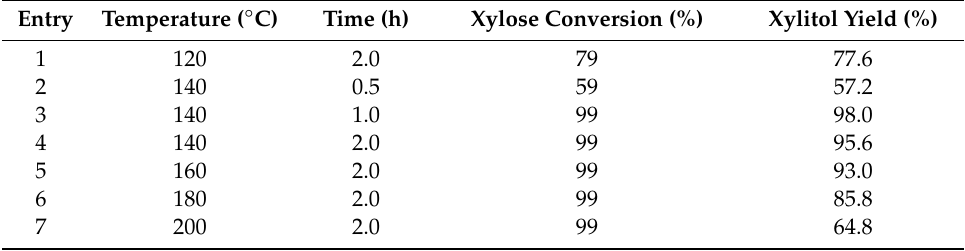
Table 2. E ff ect of di ff erent reaction conditions on the hydrogenation of xylose to xylitol a . Entry